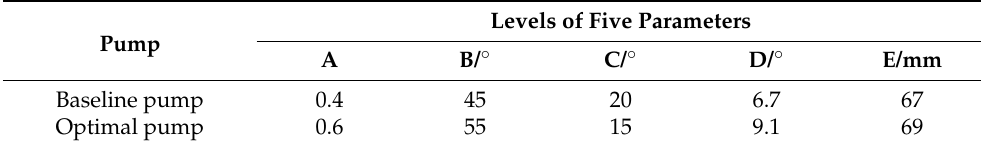
Table 7. Levels of five parameters for baseline pump and optimal pump.